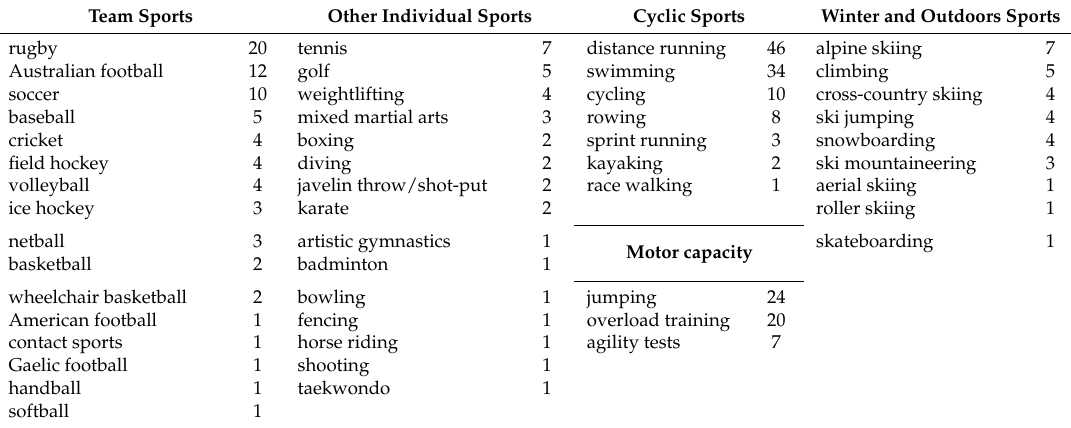
Table 3. Number of papers in which each sport has been analysed using sensors. Multiple counts are allowed for papers performing comparative studies across sports. Team